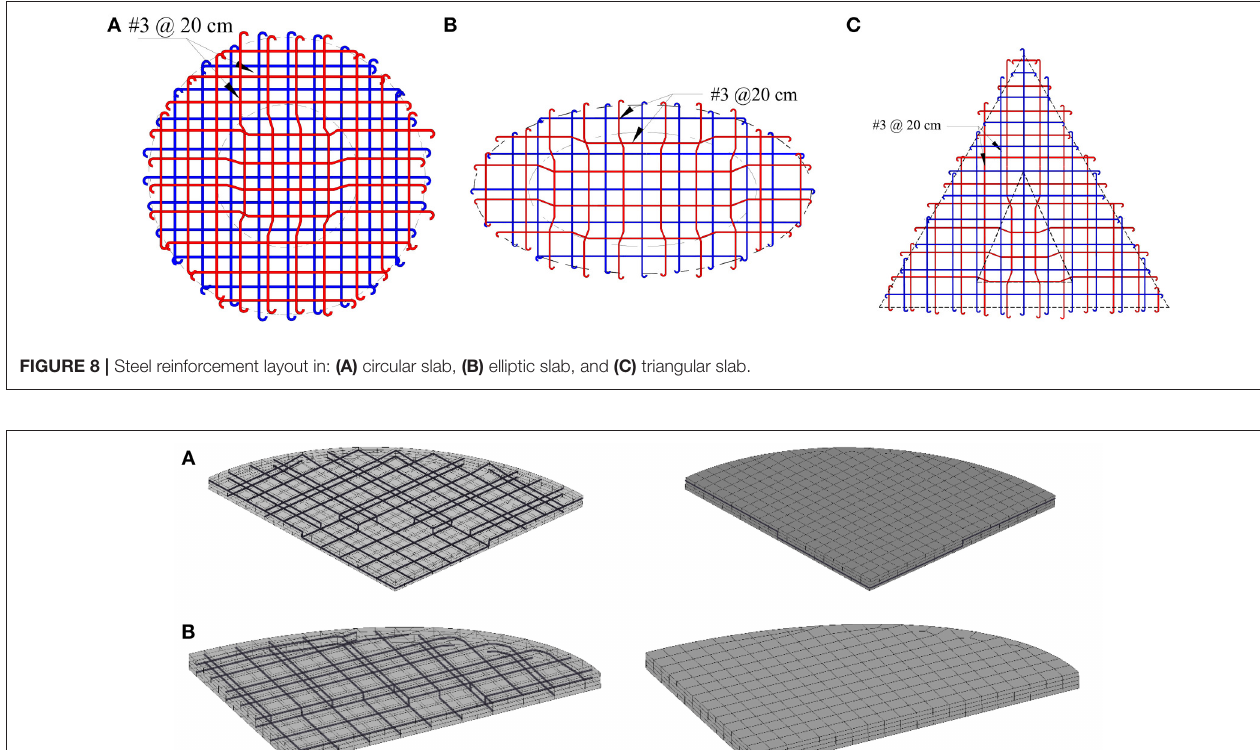
starts at the central zone on the bottom surface and it propagates to the edges as shown in Figure 13D . On the top surface, neither cracking nor crushing occurs as shown in Figure 13C